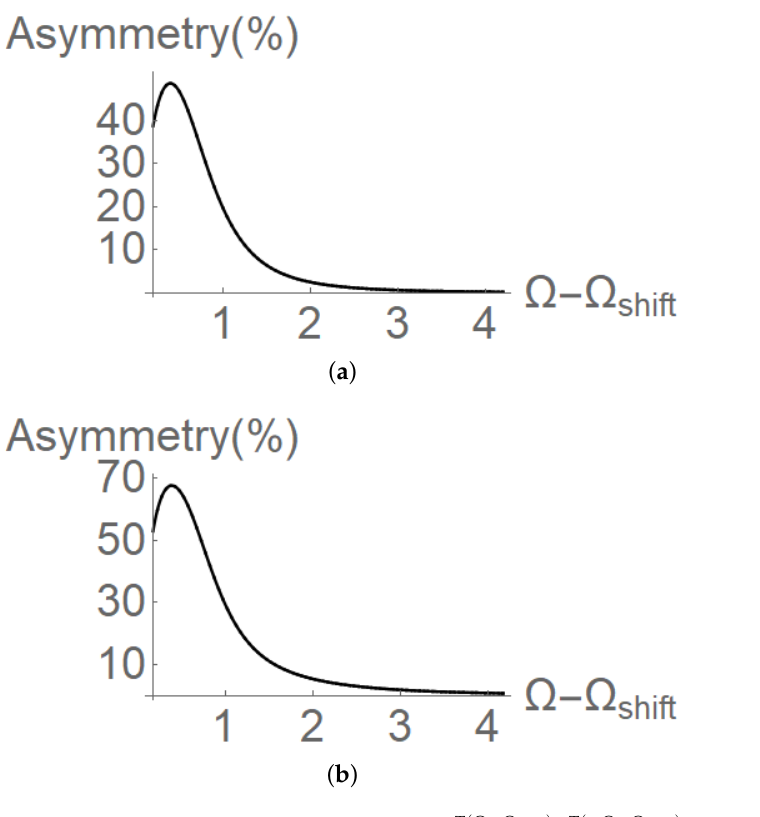
Figure 4. We plot the asymmetry coefficient ( T ized frequency for two different cloud lengths ( a ) L